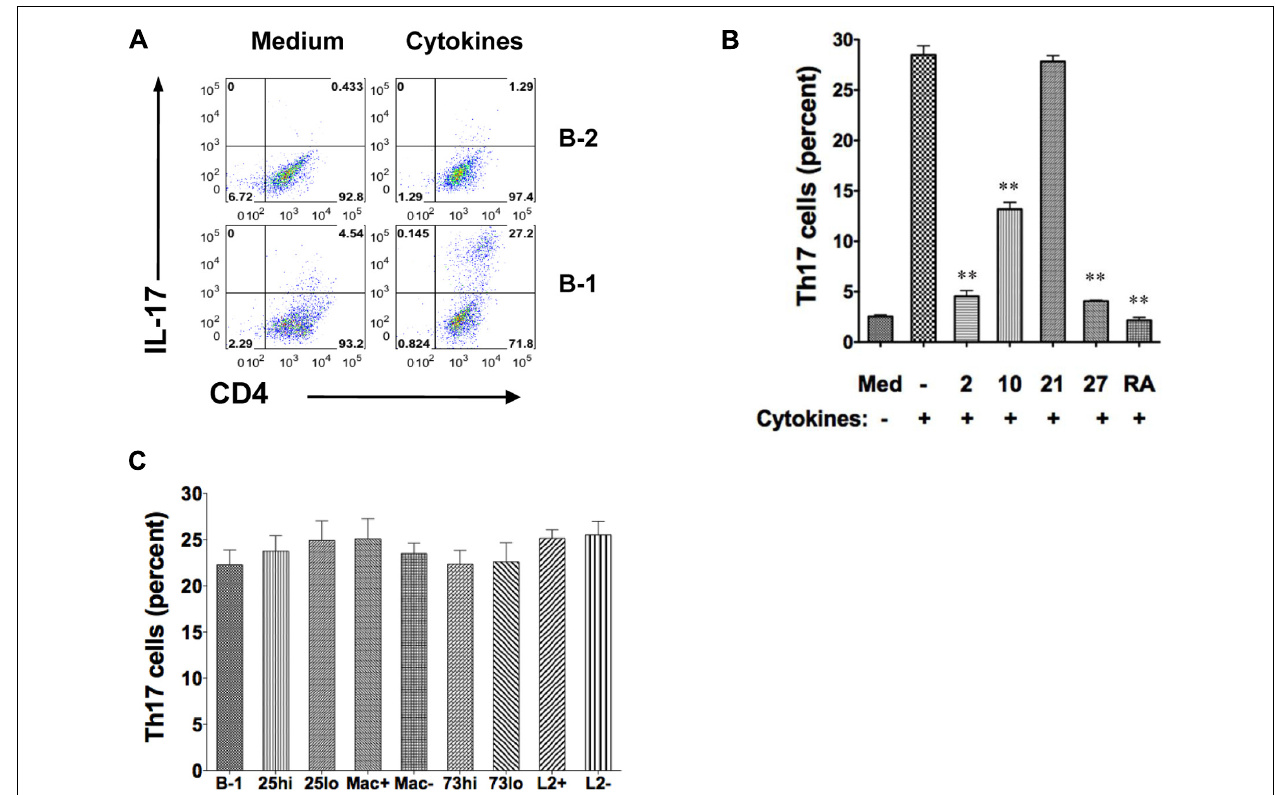
FIGURE 1 | B-1 cells, but not B-2 cells, induceTh17 cell differentiation under optimal cytokine conditions. Sort-purified BALB/c peritoneal B-1 cells or splenic B-2 cells were co-cultured for 5 days at a 1:2 ratio with magnetic bead selected CD4 + T cells from C57BL/6 mice in the presence of medium only orTh17 polarizing cytokines.The percentages of alloactivated CD4 + T cells staining positively for intracellular IL-17 are shown. (A) Expression of intracellular IL-17 was assessed in CD4 + T cells by flow cytometry after stimulation by B-1 or B-2 cells in medium only or in the presence ofTh17 polarizing cytokinesTGF β , IL-6, IL-23 plus anti-IL4 and anti-IFN γ (Cytokines). Results represent one of 3 comparable experiments. (B) Expression of intracellular IL-17 was assessed in CD4 + T cells by flow cytometry after stimulation by B-1 cells in medium only, or withTh17